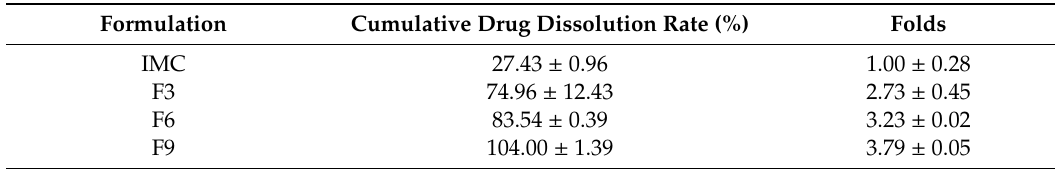
Table 2. Cumulative dissolution rate of di ff erent IMC–SDs at 90 min prepared with di ff erent carriers IMC–MSNs (F3), IMC–MSNs@Kollicoat IR (F6), IMC–MSNs@HPMC (F9) and increased folds compared to pure IMC (mean ± SD, n =